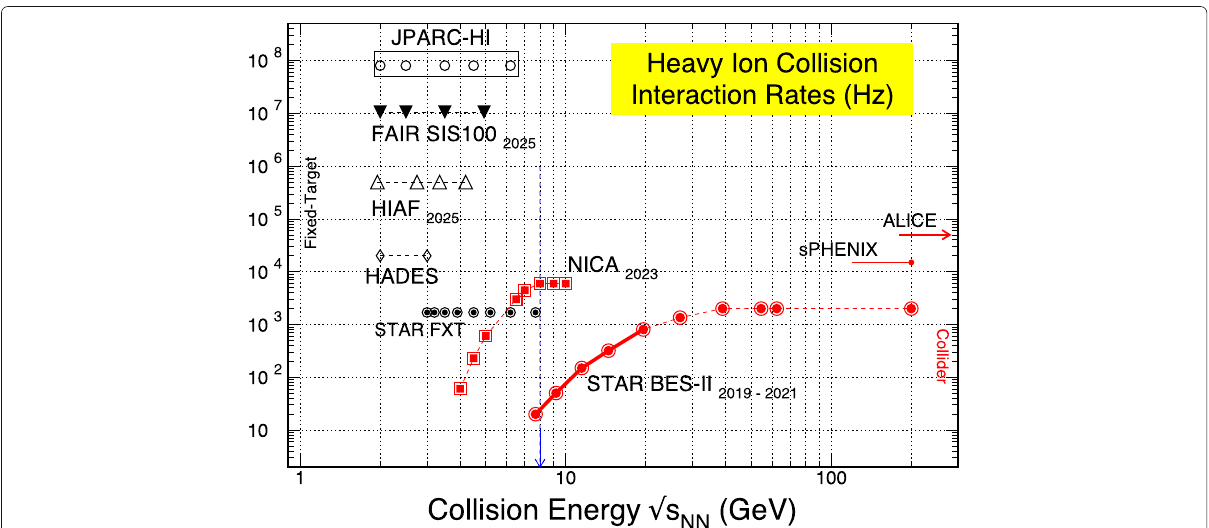
Fig. 7 Interaction rates (in Hz) for high-energy nuclear collision facilities. Collider mode: the second phase RHIC beam energy scan (BES-II) [73] for √ 7.7GeV < s NN < 19.6GeV (filled-red-circles) and NICA (filled-red-squares) [82]. Fixed target mode: STAR fixed target (FXT) program for √ s NN < 7.2GeV (filled-black-circles), FAIR (CBM, SIS) [74], HADES [83], J-PARC [84], and HIAF [85]. Also shown for reference are the 3.0GeV < expected collision rates of ALICE at LHC [86] and sPHENIX at RHIC [87]